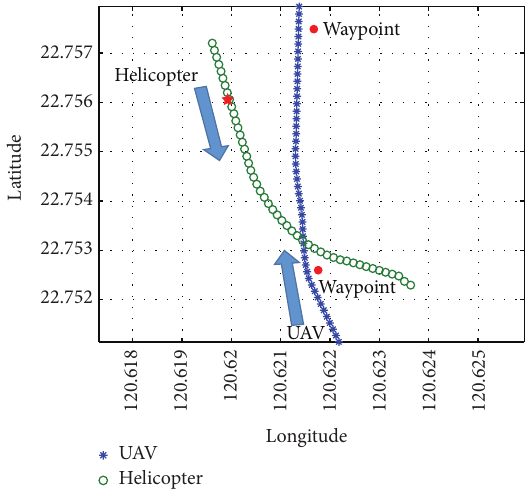
Figure 12: Flight test path of two conflicting aircraft.